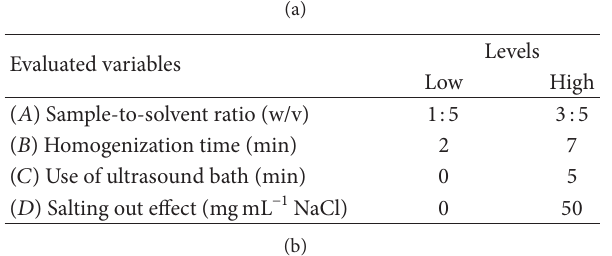
Table 1: Multifactorial experimental design 2 4 for total ITCs extraction.